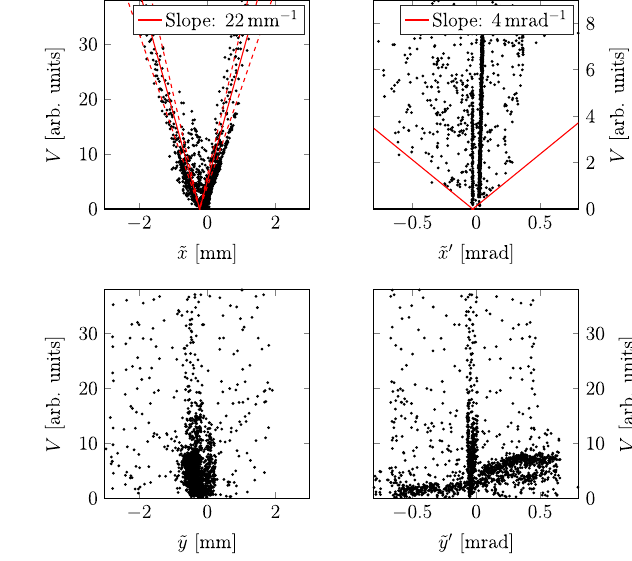
FIG. 10. Normalized amplitude V of the second dipole mode at the upstream coupler at cavity two in ACC2 as a function of the transformed horizontal beam trajectory offset ~ x (upper left), vertical offset ~ y (lower left), horizontal tilt ~ x 0 (upper right), and vertical tilt ~ y 0 (lower right). Note that each data point appears in every graph.